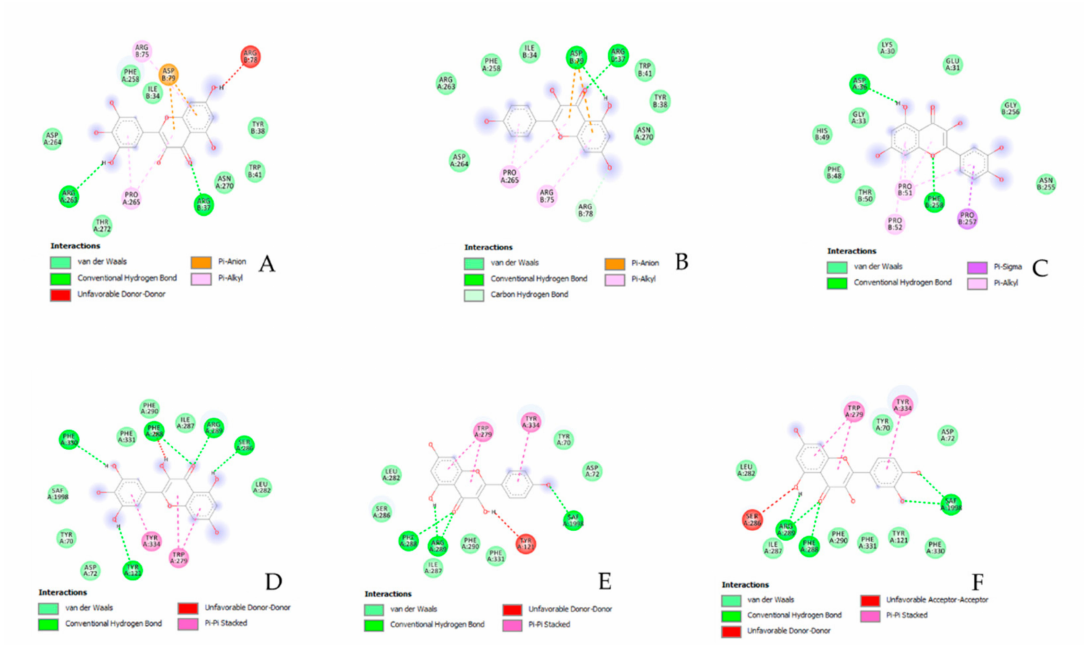
Figure 4. Putative interaction between myricetin and tyrosinase (PDB: 5I3B); Free energy of binding ( ∆ G) and affinity (Ki) are − 7.2 kcal/M and 6.3 µ M, respectively ( A ). Putative interaction between kaempferol and tyrosinase (PDB: 5I3B); Free energy of binding ( ∆ G) and affinity (Ki) are − 7.1 kcal/M and 6.3 µ M, respectively ( B ). Putative interaction between quercetin and tyrosinase (PDB: 5I3B); Free energy of binding ( ∆ G) and affinity (Ki) are − 7.0 kcal/M and 7.6 µ M, respectively ( C ). Putative interaction between myricetin and acethylcholinesterase (AchE; PDB: 1GQR); Free energy of binding ( ∆ G) and affinity (Ki) are − 8.7 kcal/M and 0.4 µ M, respectively ( D ). Putative interaction between kaempferol and acethylcholinesterase (AchE; PDB: 1GQR); Free energy of binding ( ∆ G) and affinity (Ki) are − 8.0 kcal/M and 1.4 µ M, respectively ( E ). Putative interaction between quercetin and acethylcholinesterase (AchE; PDB: 1GQR); Free energy of binding ( ∆ G) and affinity (Ki) are − 8.7 kcal/M and 0.4 µ M, respectively ( F